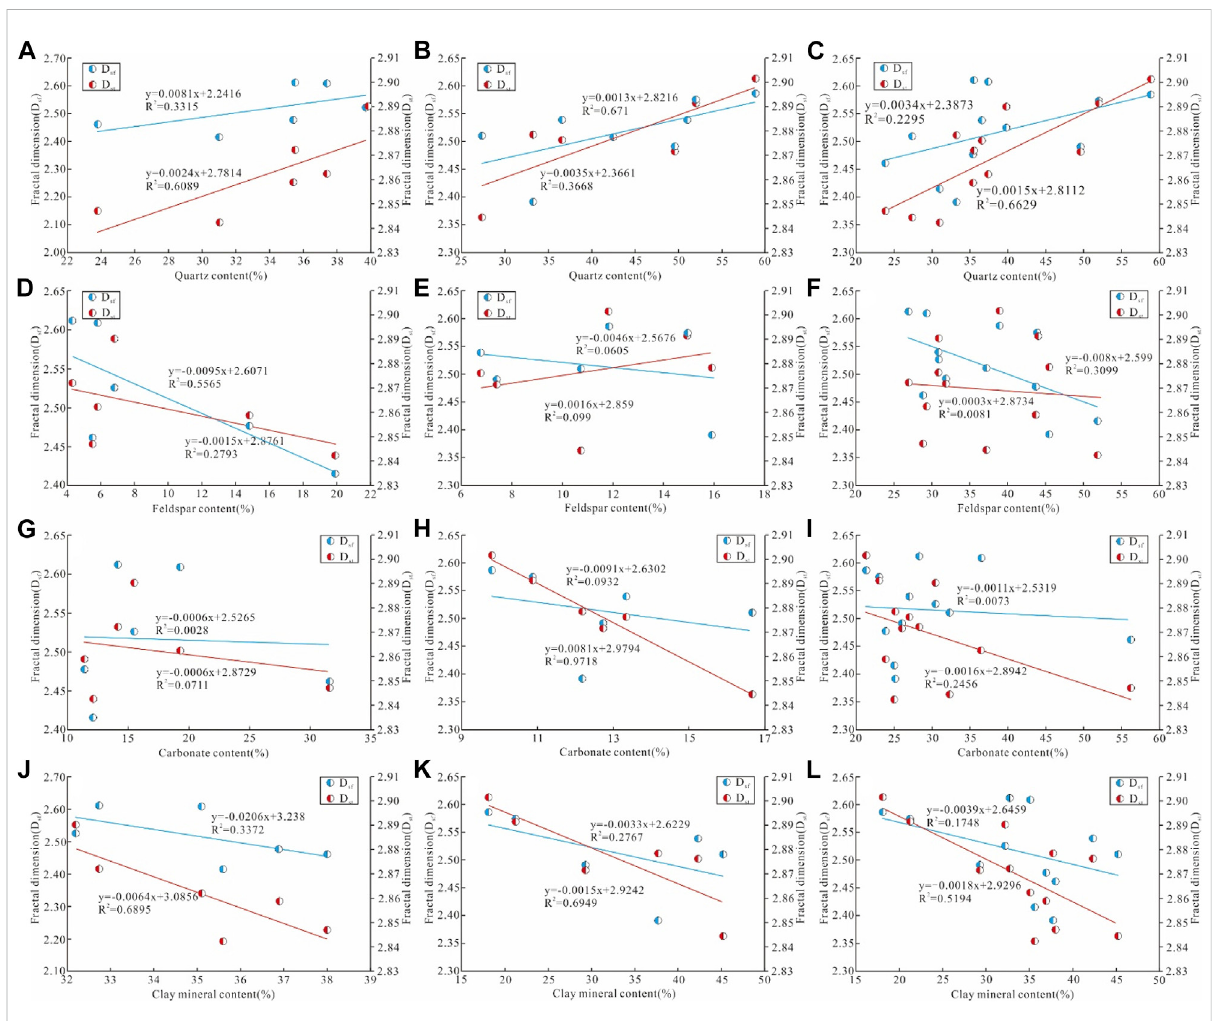
FIGURE 5 Correlation betweentheshale mineralcompositionandfractal dimensionoftheLongmaxiFormation intheChangningarea. (A – F) isfromZK1, and (G – L) is from